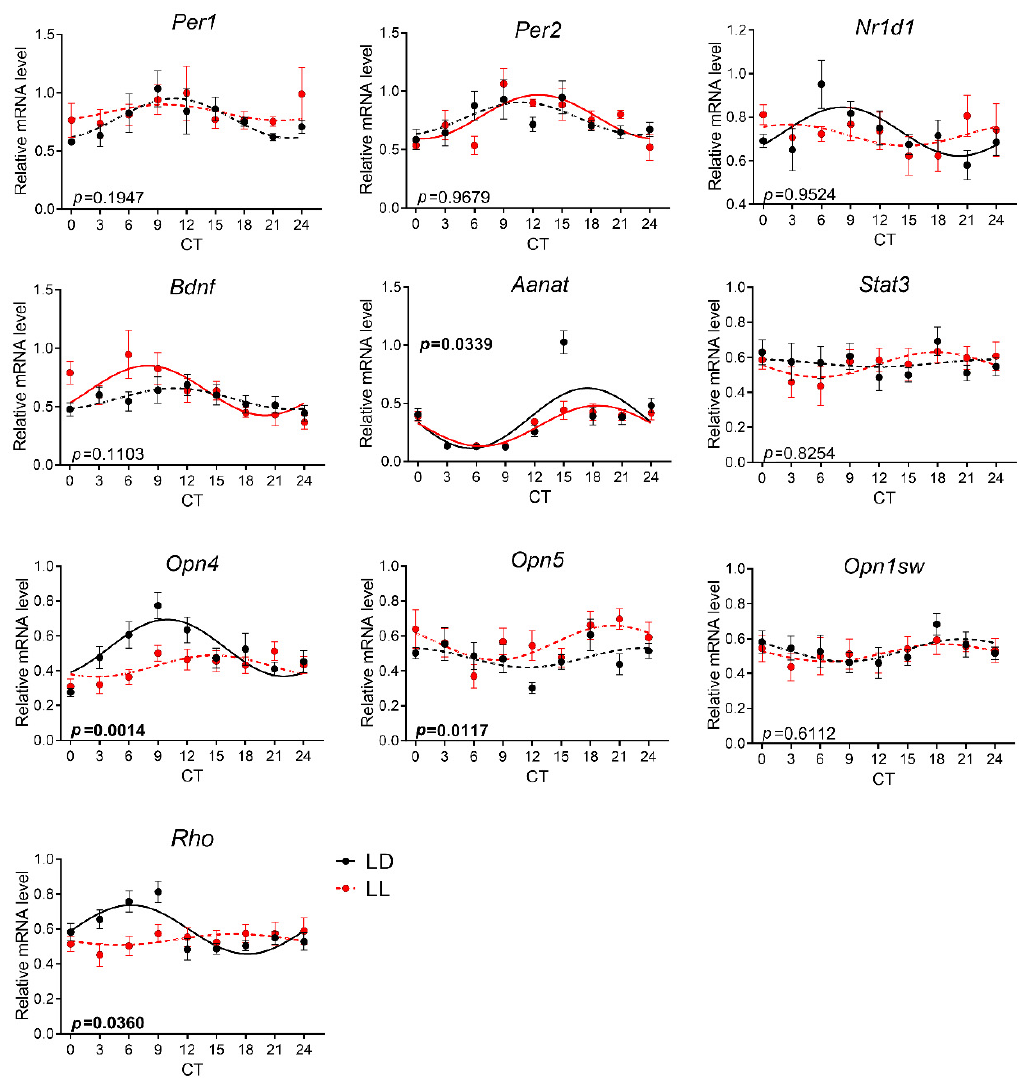
Figure 4. E ff ect of development under constant light (LL, in red; controls in LD in black) on rhythmic gene expression in retina at P30. Animals were housed under LL (16 lux) from P0 until P20 and then released into LD conditions. At P30, the animals were sacrificed in 3 h intervals in DD, and retinas were processed by qPCR with specific TaqMan probes. Rhythmicity was proved by cosinor analysis with a horizontal line as a zero hypothesis and one-way ANOVA for di ff erences between the time groups. Full lines indicate rhythms confirmed by cosinor analysis and one-way ANOVA. Dashed lines indicate profiles not confirmed for rhythmicity by one or both methods. Each point represents the mean ± SEM from six to eight animals. p -values indicate group di ff erences by two-way ANOVA, and significant values are in bold.